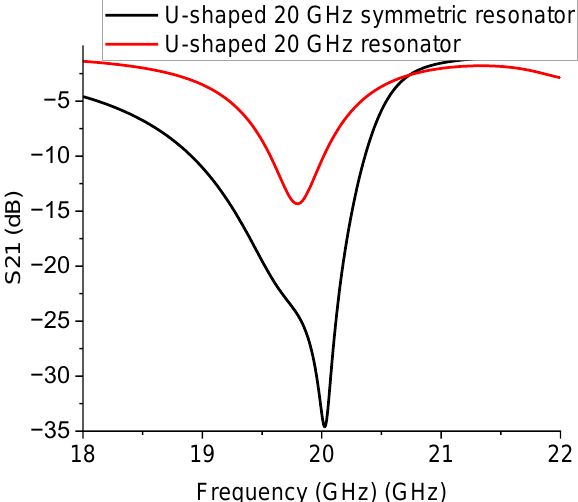
Figure 14. Comparison of the expected resonance responses for the 20 GHz single and mirrored resonators.